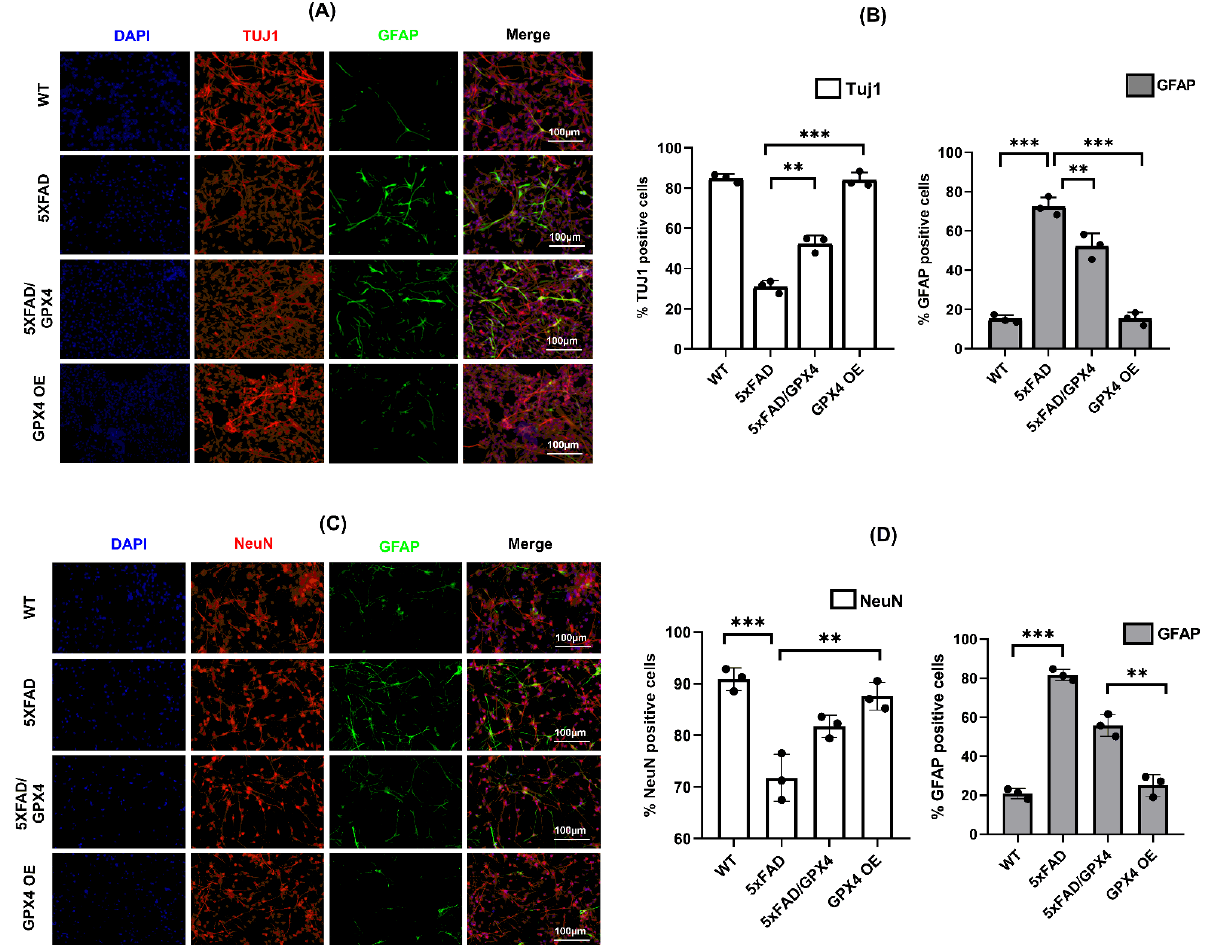
Figure 5. Levels of neuronal and astrocytic markers in differentiated NSCs culture assessed by immunofluorescence ( A ). Immunofluorescent images representing the expression of Tuj1 (Red) and GFAP (Green) in differentiated NSCs cultures. The cultures were also stained with nuclear stain DAPI (blue). ( B ). % of cells positive against Tuj1 and GFAP among differentiated WT, 5×FAD, 5×FAD/GPX4 and GPX4 OE NSCs cultures out of the total number of cells stained with DAPI ( C ). Immunofluorescent images representing the expression of NeuN (Red) and GFAP (Green) in differentiated NSCs cultures. The cultures were also stained with nuclear stain DAPI (blue). ( D ). % of cells positive against NeuN and GFAP among differentiated WT, 5×FAD, 5xFAD/GPX4 and GPX4 OE NSCs cultures out of the total number of cells stained with DAPI. Fluorescence intensity of TUJ1, NeuN and GFAP was measured using Image J software and expressed as % of positive cells against each protein. **: p < 0.01, ***: p < 0.001.